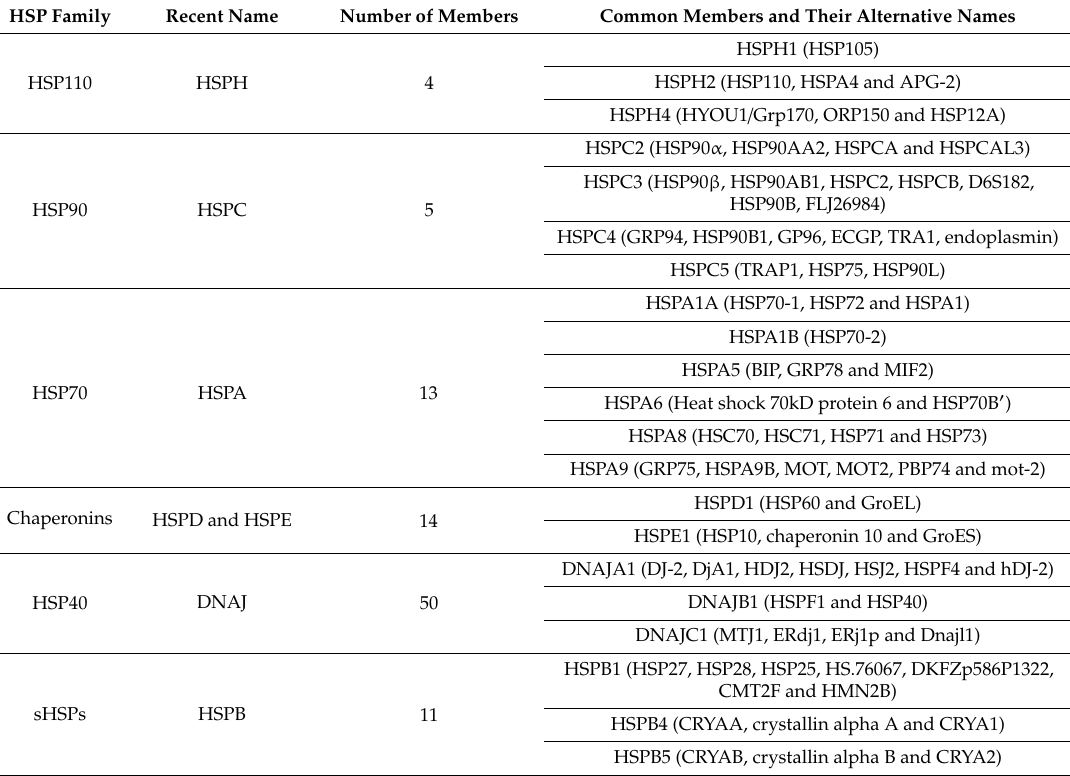
Table 1. General overview of human heat shock proteins (HSP) families and common members [27]. HSP